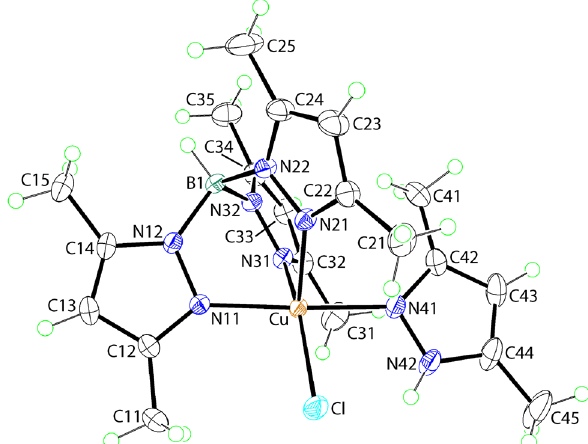
Table  : Data collection and